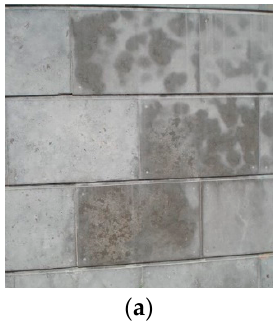
Figure 4. Illustrative examples of the visual anomalies observed in NSC: ( a ) damp stains; ( b ) biological colonisation; ( c ) dirt deposition; ( d ) efflorescence.